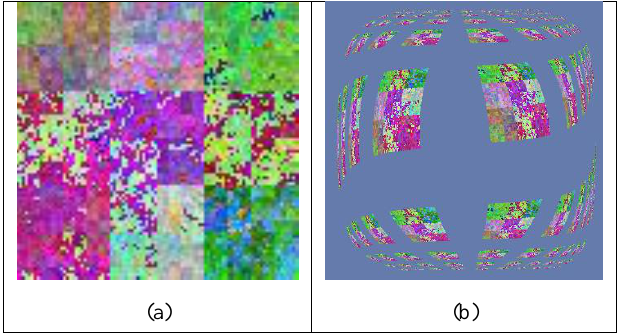
Figure 8. Triangulation error on different elevations.